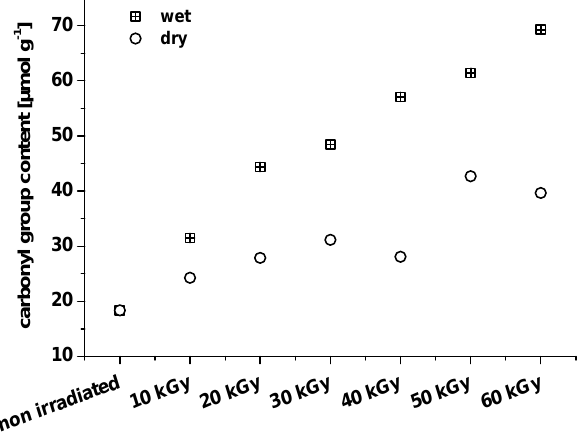
Figure 8. Development of the total carbonyl group content in MFC upon electron beam irradiation in wet and in dry conditions.